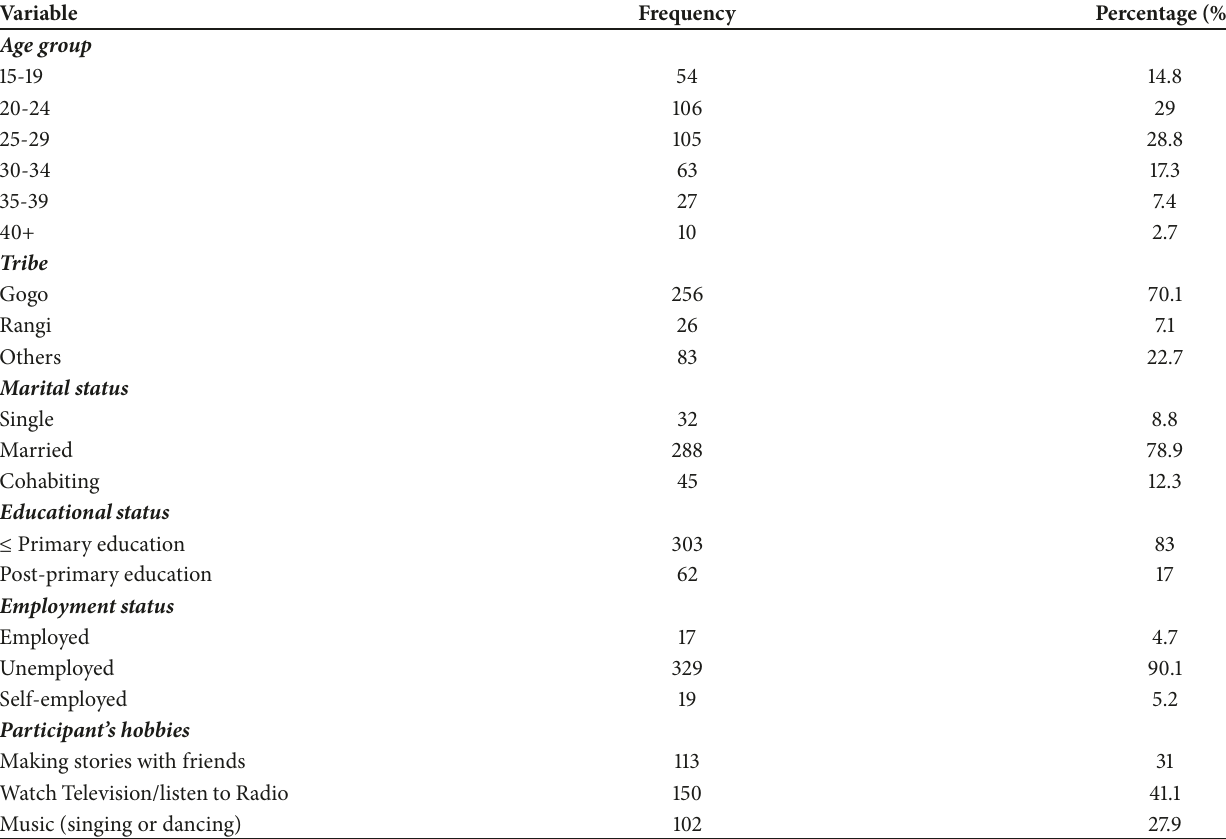
Table 1: Participants’ distribution by sociodemographic and reproductive profile (n=365).